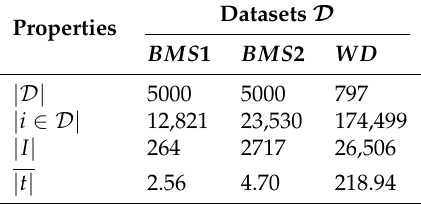
Table 3. Properties of D